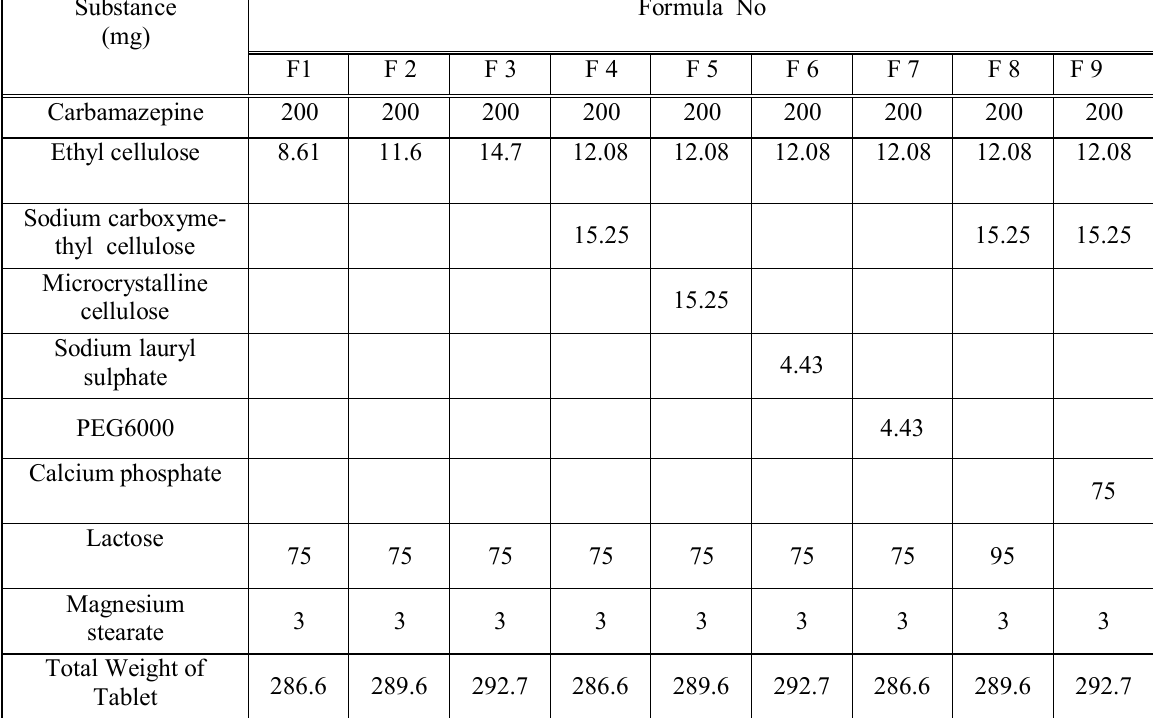
Table 1: Formulation of CBZ tablet using ethyl cellulose with different additives.